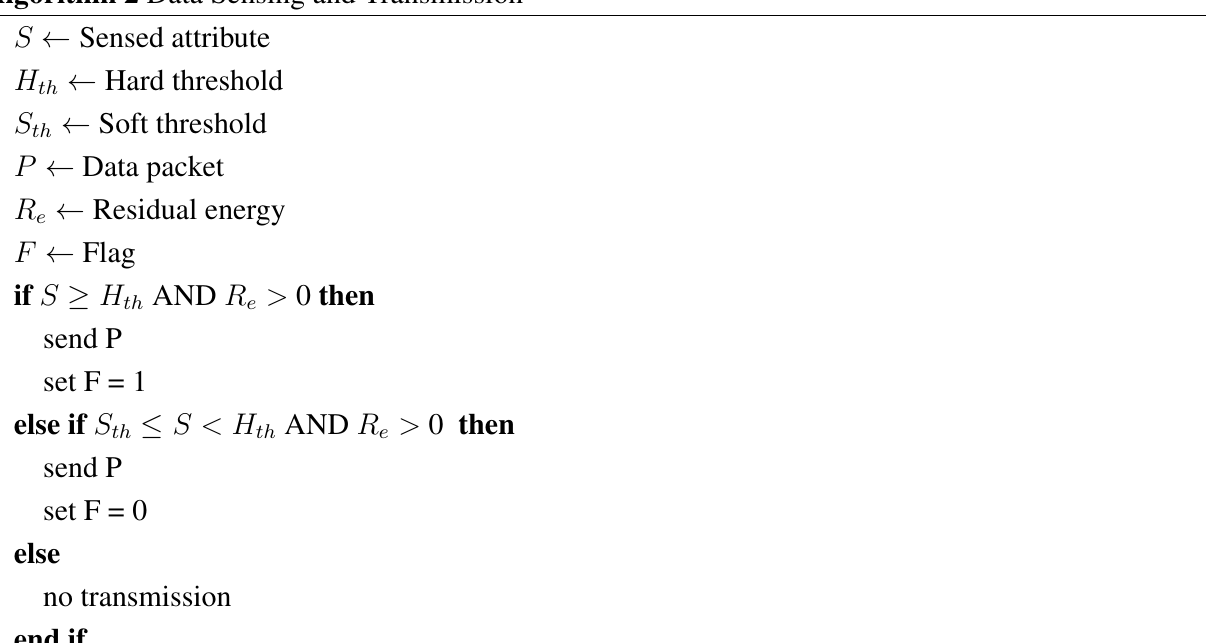
Algorithm 2 Data Sensing and